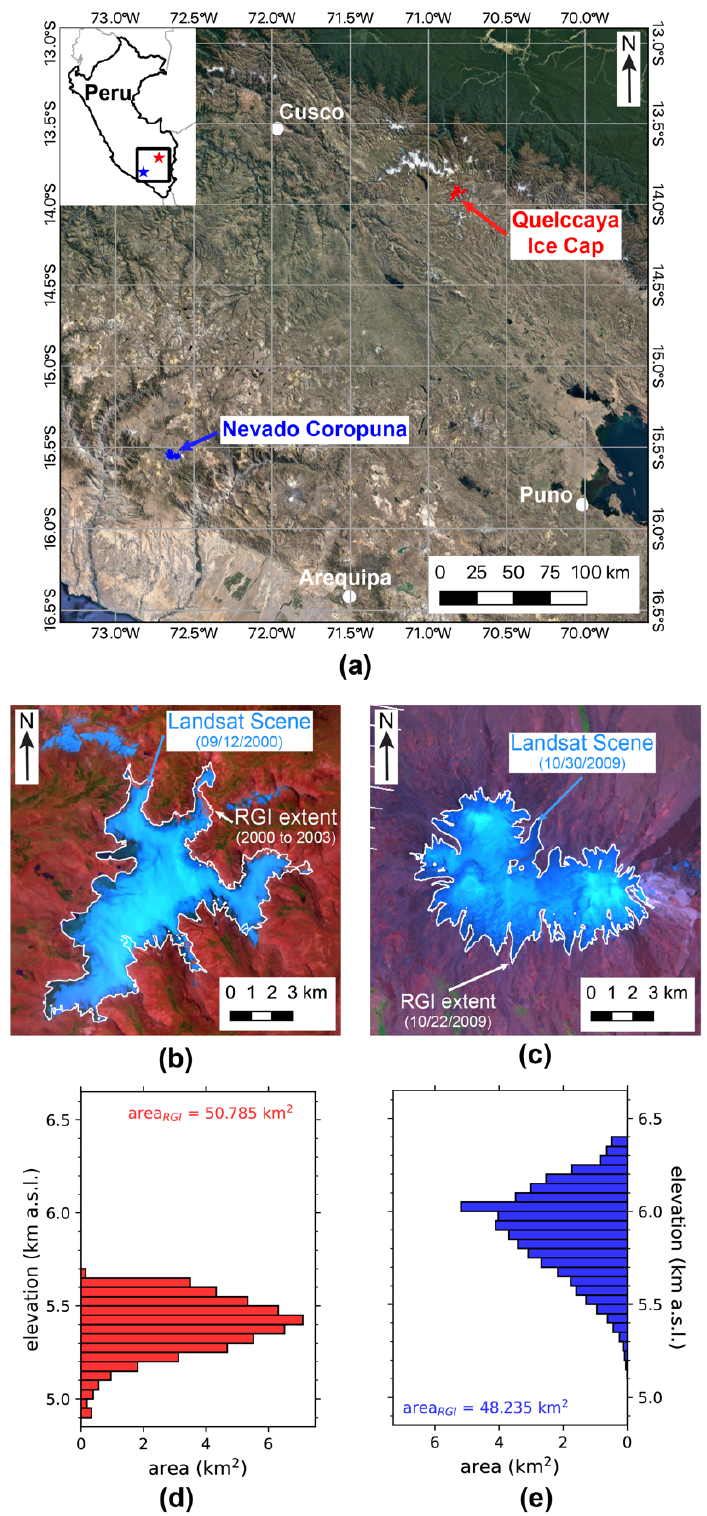
Figure 1. Setting of ( a,b,d ) the Quelccaya Ice Cap and ( a,c,e ) Nevado Coropuna within ( a ) southern Peru, ( b , c ) false-color composite (SWIR2-NIR-Green) Landsat images of the two ice masses overlayed with their extents in the Randolph Glacier Inventory (RGI), and ( d , e ) area-elevation distributions of the two ice masses from the RGI.